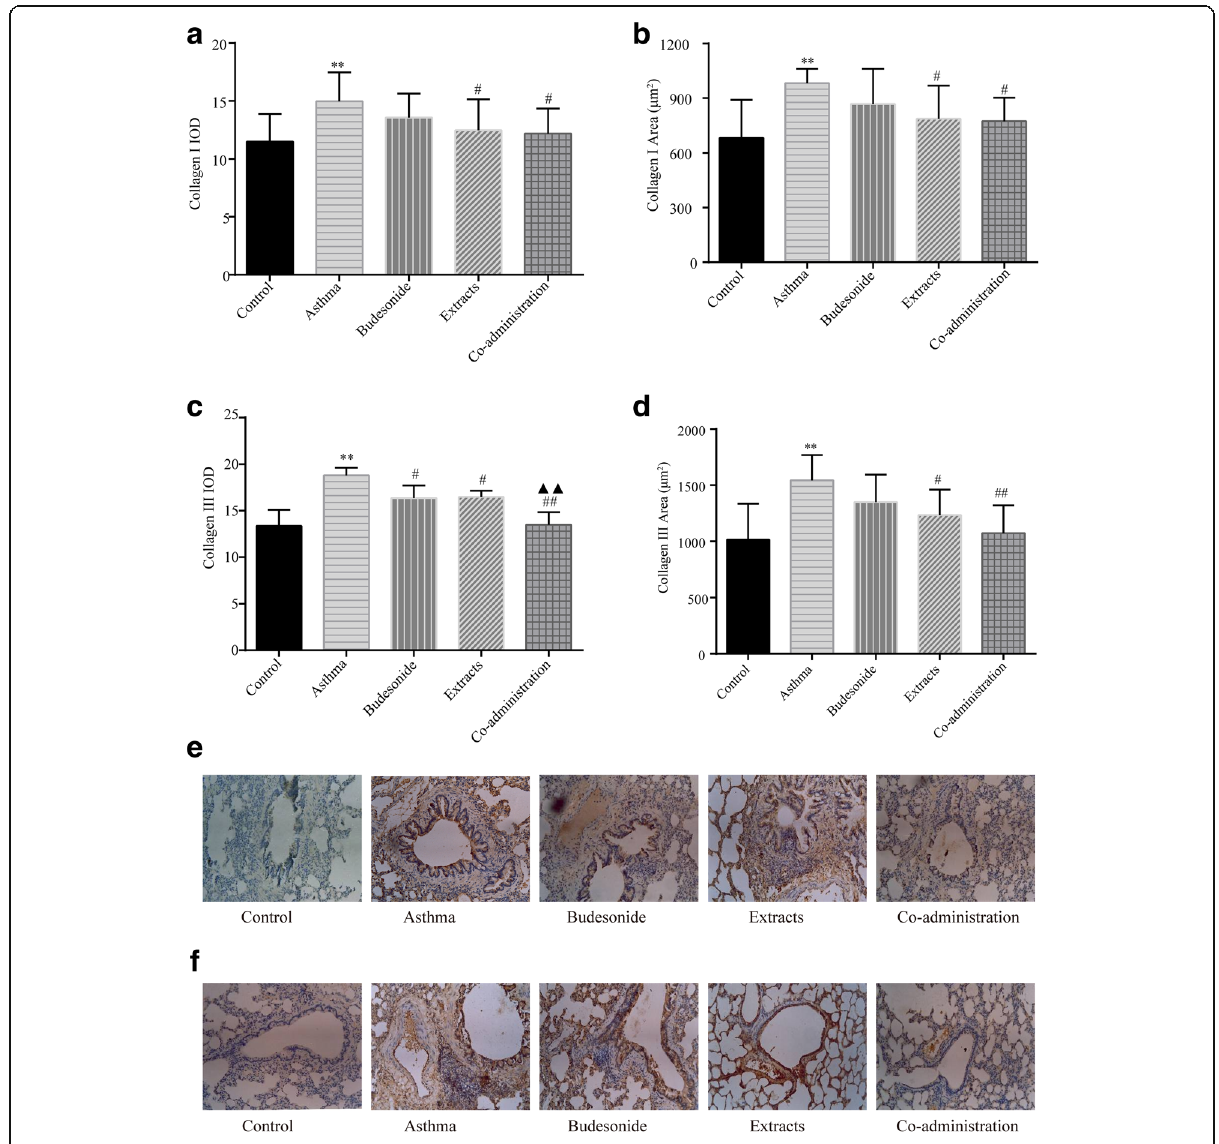
Fig. 4 Effects of budesonide and the herbal extracts on expression of collagen I and collagen I. Expression of the two types of collagen in lung tissue was determined by immunohistochemical staining. ( a ) IOD of collagen I. ( b ) Positive area of collagen I. ( c ) IOD of collagen III. ( d ) Positive area of collagen III. ( e ) Representative photomicrographs of collagen I from immunohistochemical-stained lung sections (×400). ( f ) Representative photomicrographs of collagen III from immunohistochemical-stained lung sections (×400). Mean ± SD, n = 8. ** P < 0.01 compared to normal control group; # P < 0.05 and ## P < 0.01 compared to asthma model group; ▲▲ P < 0.01 compared to budesonide